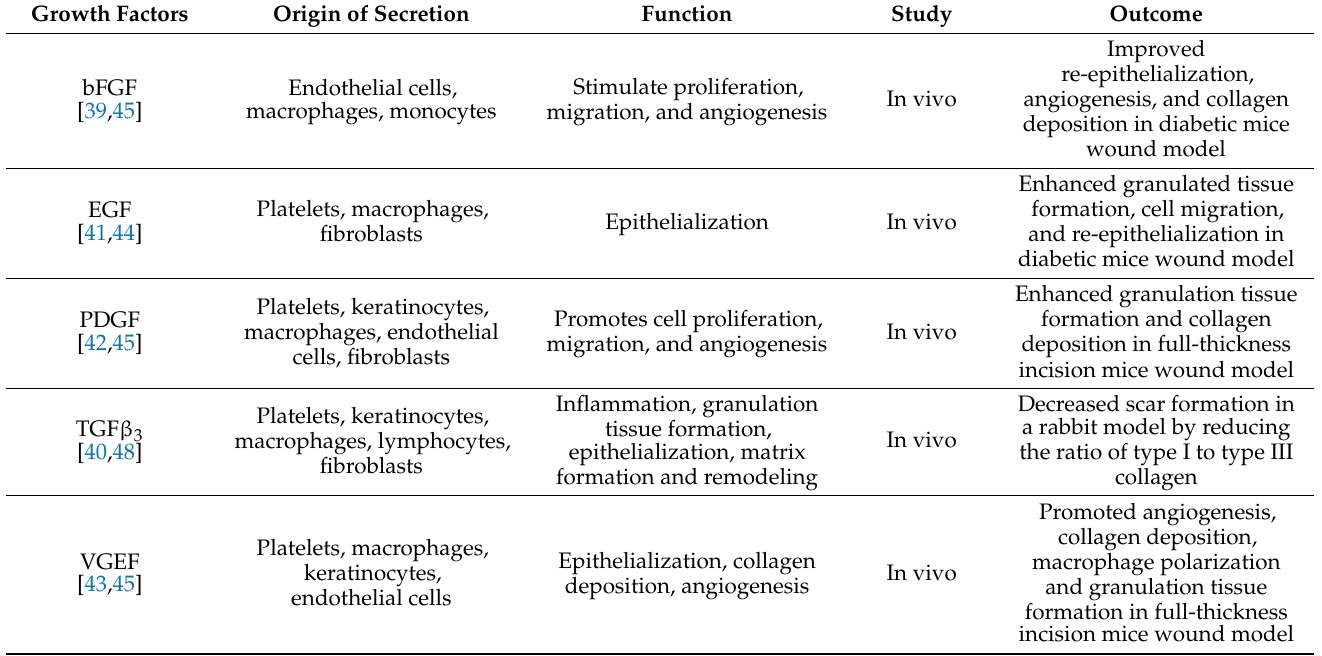
Table 2. Function of various GFs and their outcome in wound